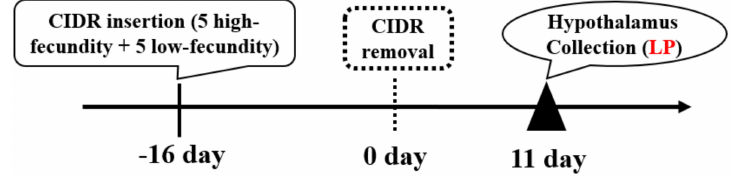
Figure 1. Simultaneous estrus processing and sampling. LP denotes the luteal